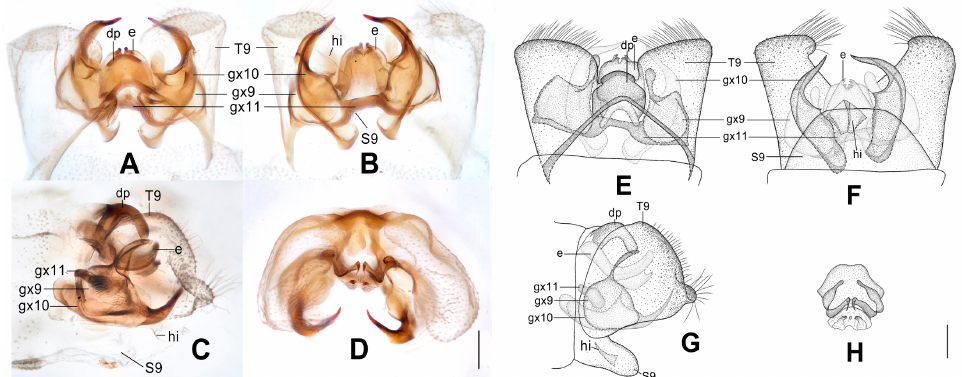
Figure 11. Dilar rauschorum sp. nov. ( A – D ) male holotype, genitalia, photographs: ( A ) dorsal view; ( B ) ventral view; ( C ) lateral view; ( D ) caudal view. ( E – H ) male holotype, genitalia, line drawings: ( E ) dorsal view; ( F ) ventral view; ( G ) lateral view; ( H ) ectoproct, caudal view. dp: dorsoprocessus;